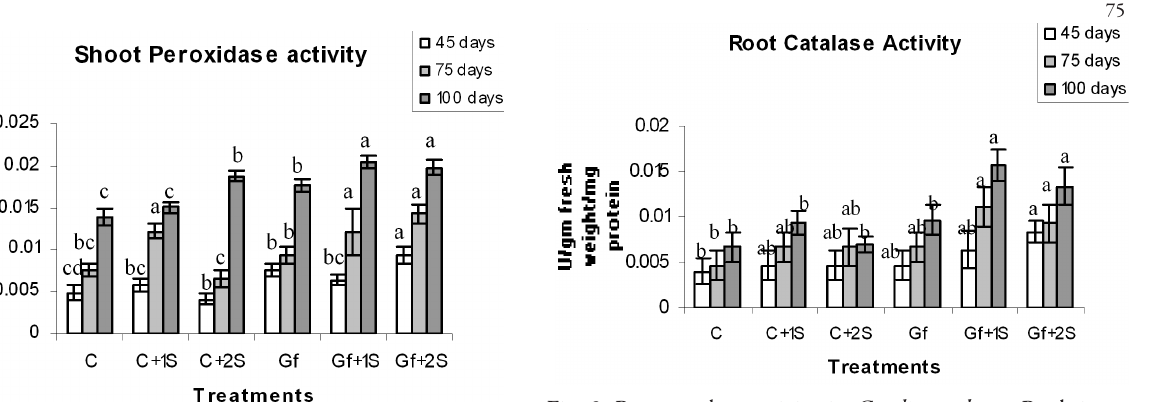
Fig. 9. Root catalase activity in Gmelina arborea Roxb inocu- lated with Glomus fasciculatum after 45, 75 and 100 days after AM inoculation